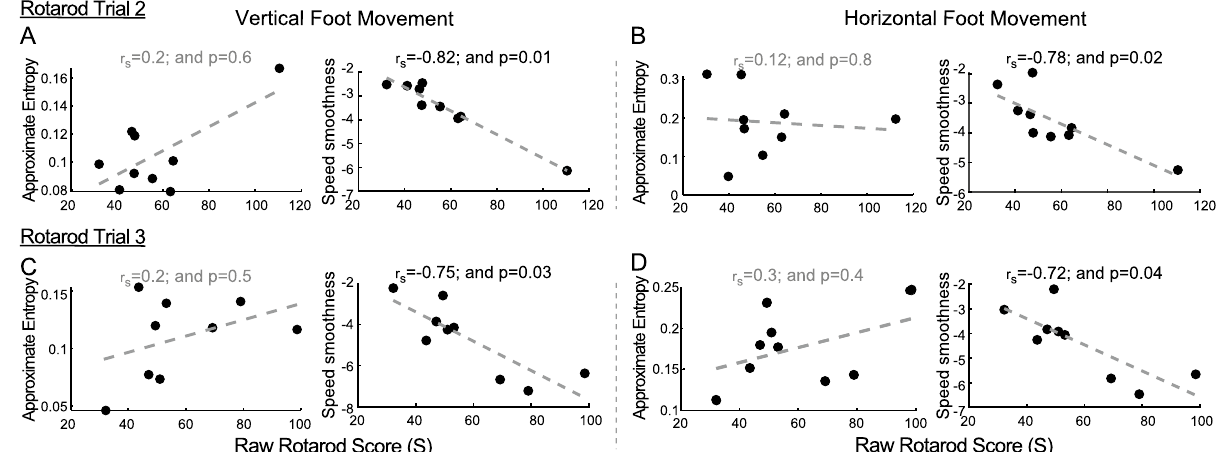
Figure 6. Relationship between second and third trial vertical and horizontal paw position intra-session features and rotarod scores. ( A , B ) Relationship of vertical and horizontal paw position approximate entropy and speed smoothness with rotarod scores across all mice during their second trial. ( C , D ) Relationship of vertical and horizontal paw position approximate entropy and speed smoothness with rotarod scores for the mice during their third trial. Graphs are scatter plots for intra-session features with their best fit line. Spearman correlation coefficient rho (r s ) and a measure of statistical significance (“p”) is provided for each